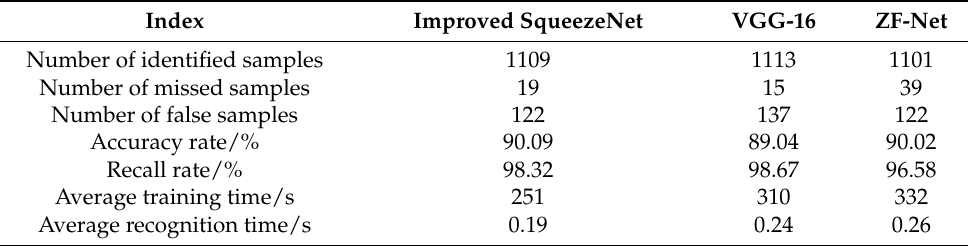
Table 5. Relief hole target recognition results based on different basic network models.